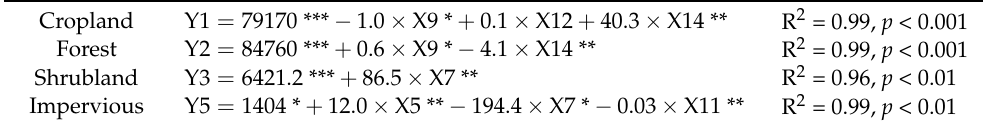
Table 7. Multivariate linear stepwise regression results of the area of land-use types and driving factors.